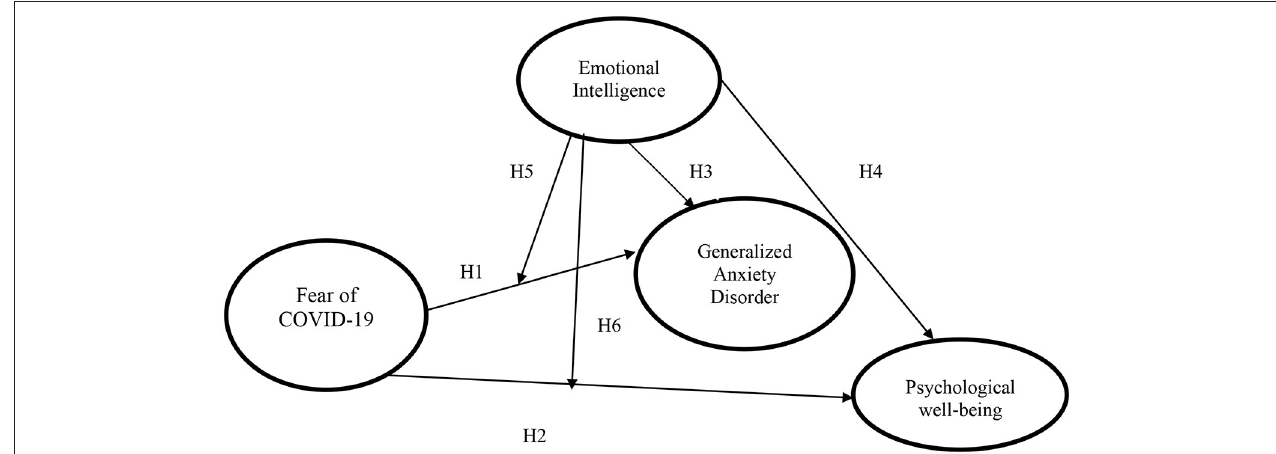
FIGURE 1 | Conceptual study